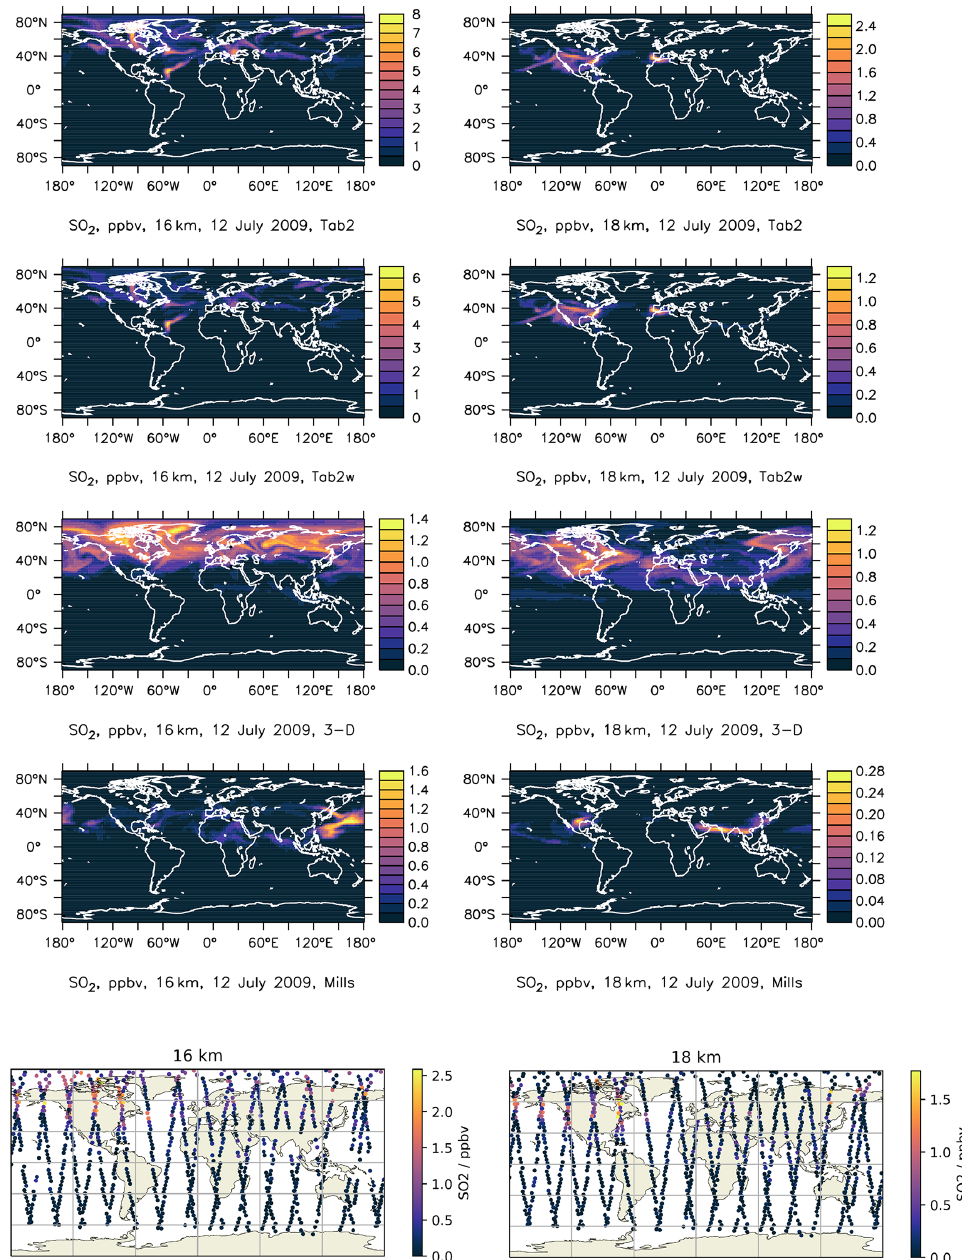
Figure C5. SO 2 mixing ratio (ppb) maps after the Sarychev eruption at 16km (left column) and 18km (right column) for point sources of Table 2 in the column between 15 and 17km (first row), the column between 13 and 17km (second row), our three-dimensional approach (third row) and the point source assumption of Mills et al. (2016) with a column below 15km (Manda Hararo neglected) (fourth row). Bottom row from MIPAS